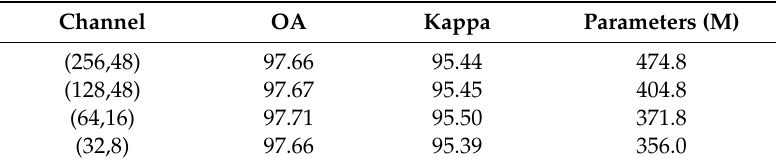
Table 3. Comparison of network classification performance and parameters with di ff erent channel combinations.